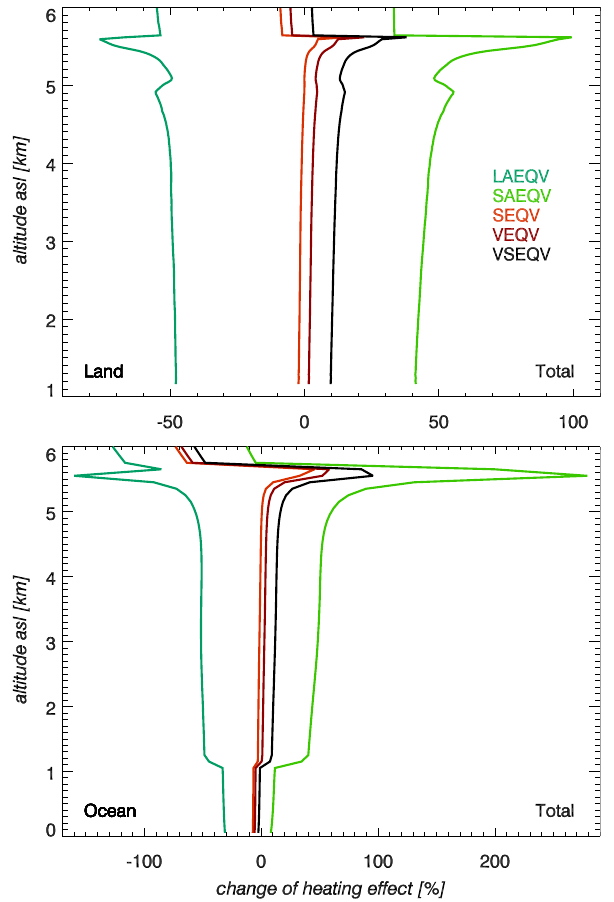
Fig. 20. Changes of total heating effect 1H(z) of the Saharan mineral dust plume, observed on 19 May 2006 over OZT site about noon, caused by prolate spheroidal particles compared to spherical ones, assuming various cases of size equivalence (LAEQV, SAEQV, SEQV, VEQV and VSEQV). Mineral dust over a mean land (top) and ocean surface